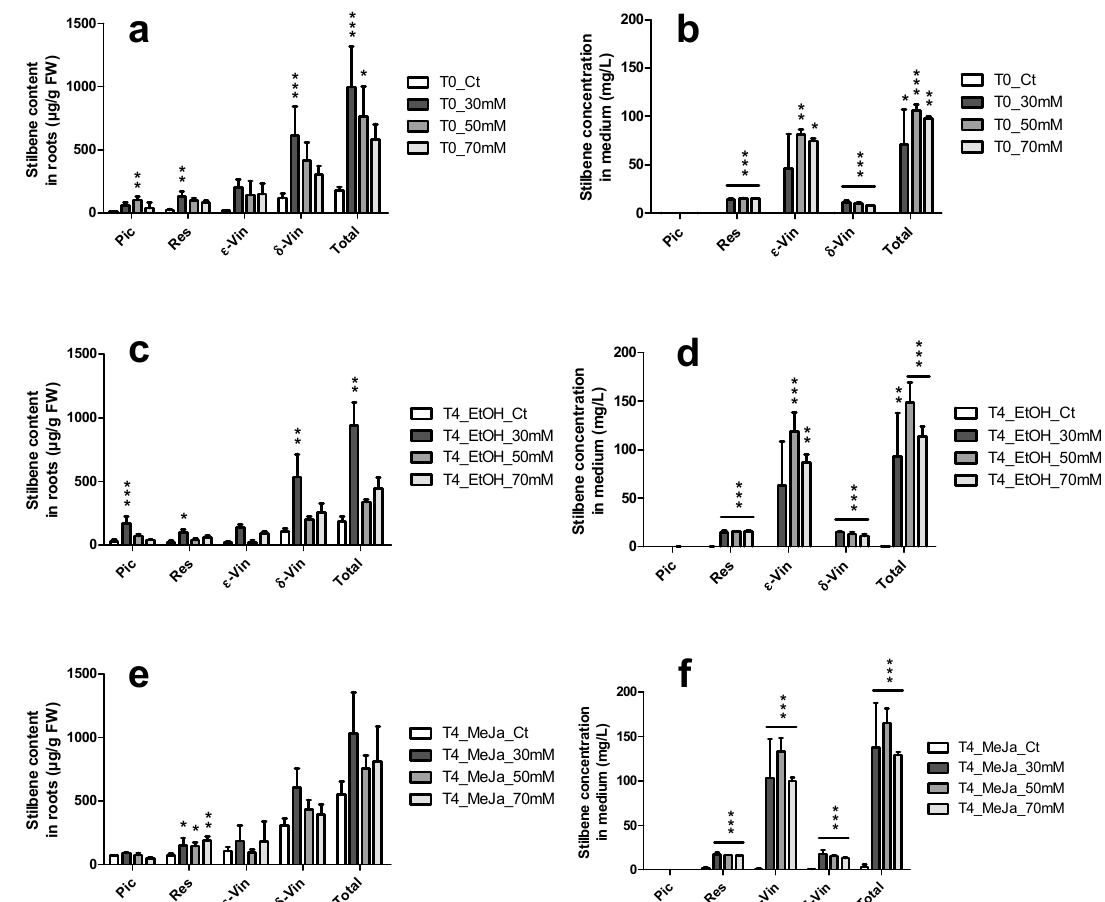
Figure 8. Amounts of stilbenes produced in response to treatments with MCDs in the culture media over time. Stilbene measured in HRs and in the culture medium, respectively: ( a , b ) after 18 days of culture and before applying 100 µ M MeJA or EtOH; ( c , d ) four days after applying EtOH; and ( e , f ) four days after applying MeJA at 100 µ M. Each point represents the mean with standard deviation of three biological replicates. Pic: piceid; Res: resveratrol; ε -vin: ε -viniferin; δ -vin: δ -viniferin. Each value was compared to its corresponding control using ANOVA test (* p < 0.5, ** p < 0.01, *** p < 0.001)